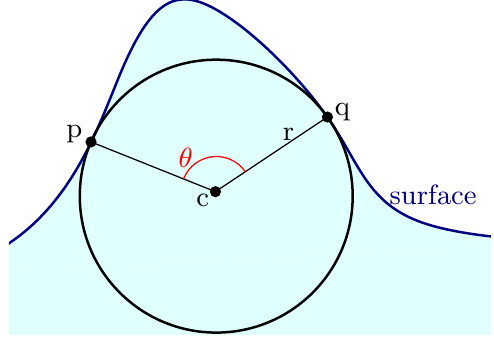
Figure 4. Key geometric characteristics of a medial